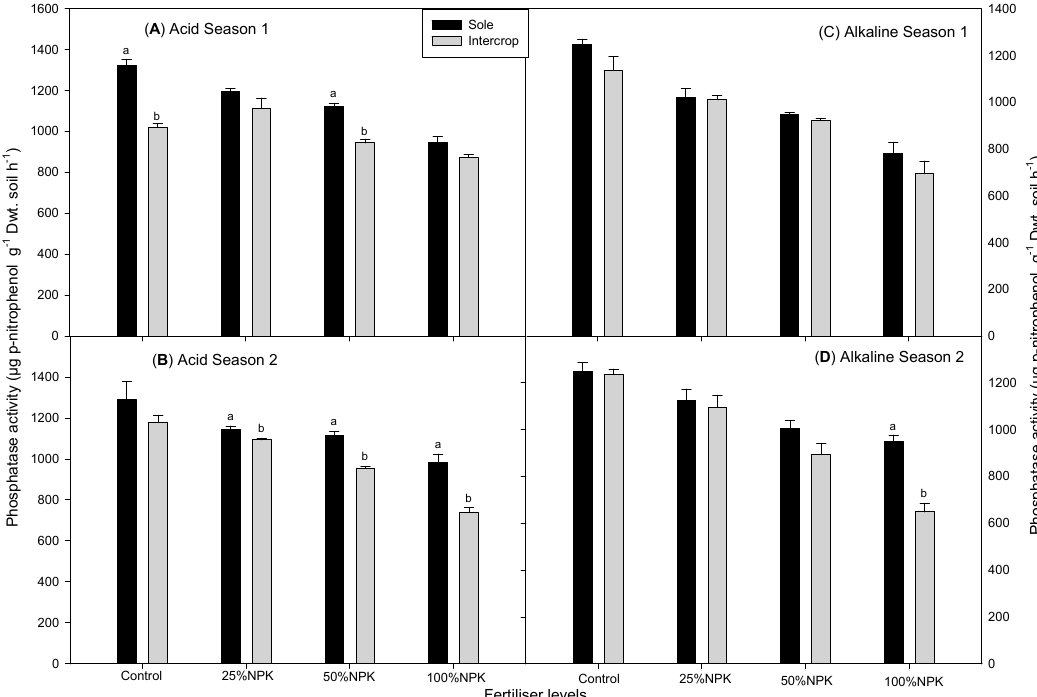
Figure 3. Two-way analysis showing the e ff ects of fertilizer levels and cropping on acid and alkaline phosphatase activity on rhizosphere of amaranth at four NPK levels in ( A , B ) 2014 / 15 and ( C , D ) 2015 / 16 seasons. Each bar represents the mean ± SE (n = 4). Di ff erent letters in each fertilizer treatment show significant di ff erences at p ≤ 0.05 in sole or